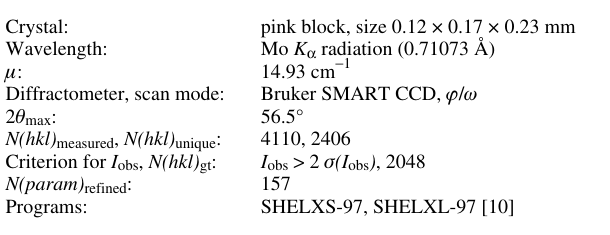
Table 1. Data collection and handling.